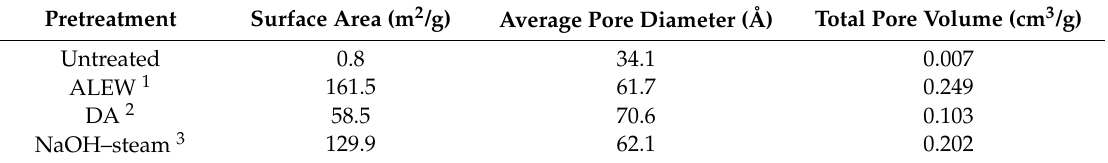
Table 4. Effects of the pretreatment conditions on the surface areas, average pore sizes, and pore volumes of the critical point drying (CPD) Eucalyptus samples.